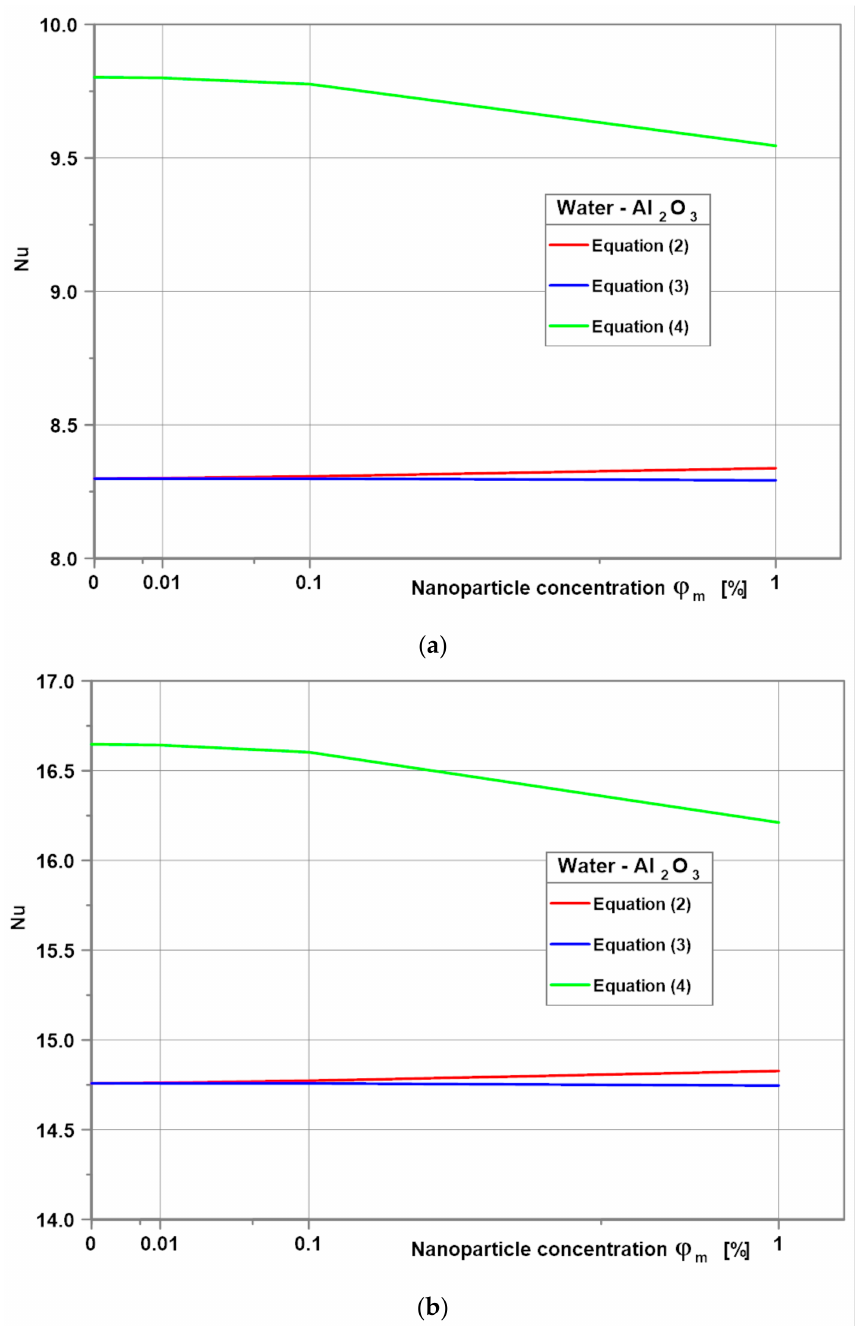
Figure 10. Variation of Nusselt number with nanoparticle mass concentration for water-Al 2 O 3 nanofluids for Ra = 10 5 ( a ) and Ra = 10 6 ( b